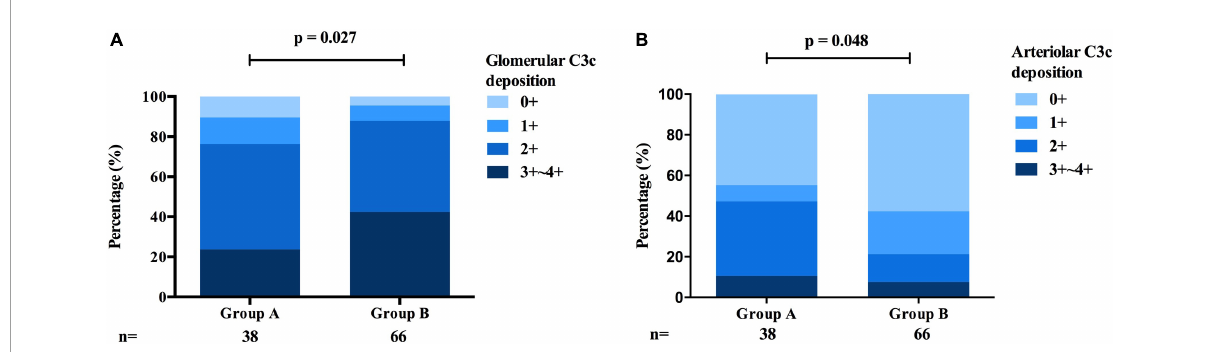
FIGURE5 Comparison of the deposition of C3c between the arteriolar lesions group and the proliferative lesions group of patients with IgAN. (A) The intensity of C3c deposition in the glomerular mesangial and capillary areas was more severe in the proliferative lesions group than in the arteriolar lesions group. (B) The intensity of C3c deposition in intrarenal arterioles was more severe in the arteriolar lesions group than in the proliferative lesions group.